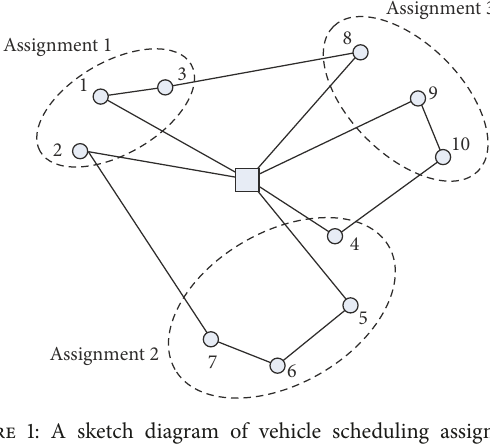
Figure 1: A sketch diagram of vehicle scheduling assignments converted to